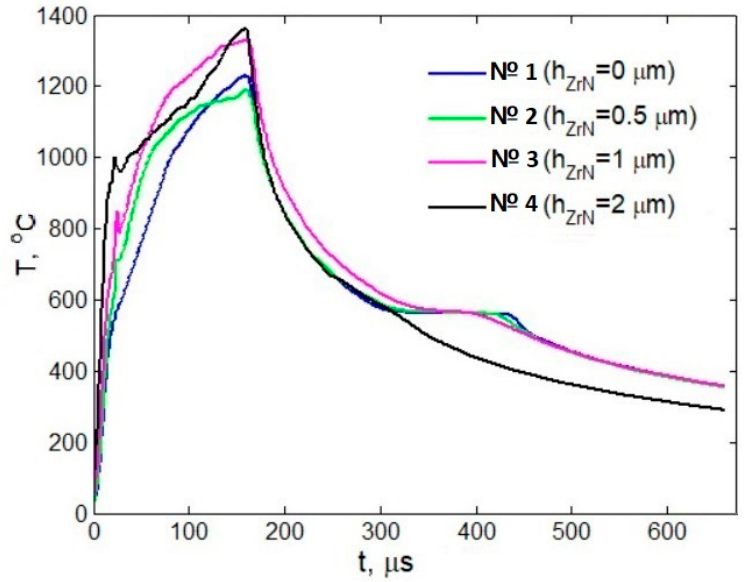
Figure 7. Time variations of the surface temperature of the bare and coated silumin during electron beam treatment.